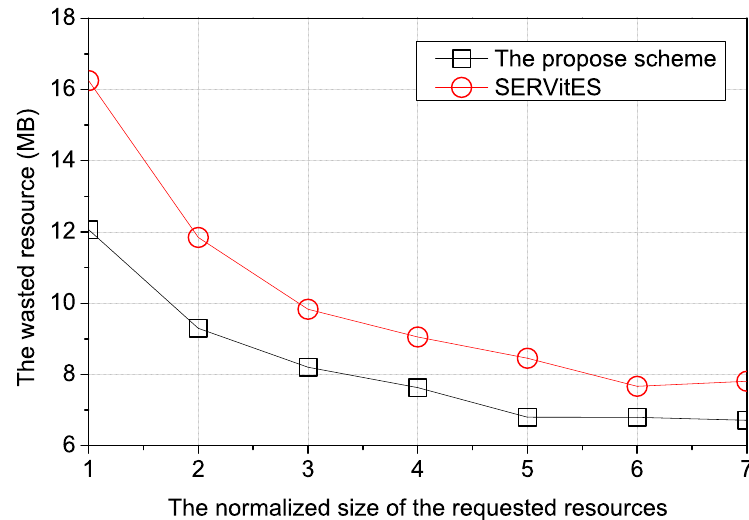
Figure 4. The wasted resources for normalized sizes of requested resources.